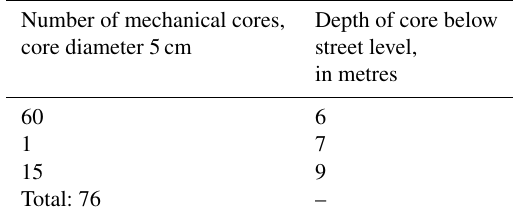
Table 1. Metrical data of cores in Vlaardingen Stadshart (city cen-